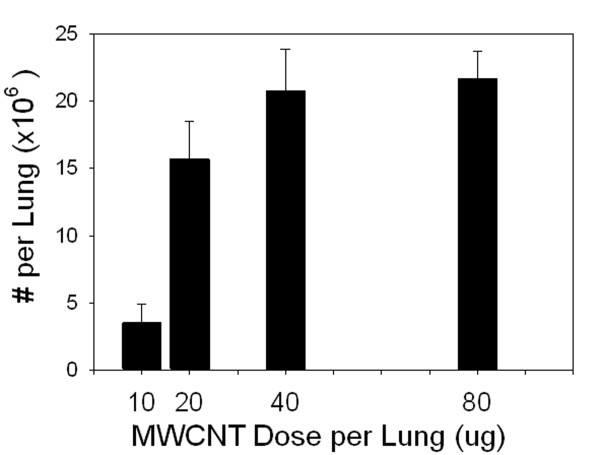
Morphometric determination of the number of alveolar epithelial penetrations versus dose 56 days after aspiration. The number of MWCNT penetrations per lung versus aspiration dose of MWCNT demonstrated a sigmoidal dose-response with an ED50 of 15.3 μg. (Mean ± SE, N = 8).